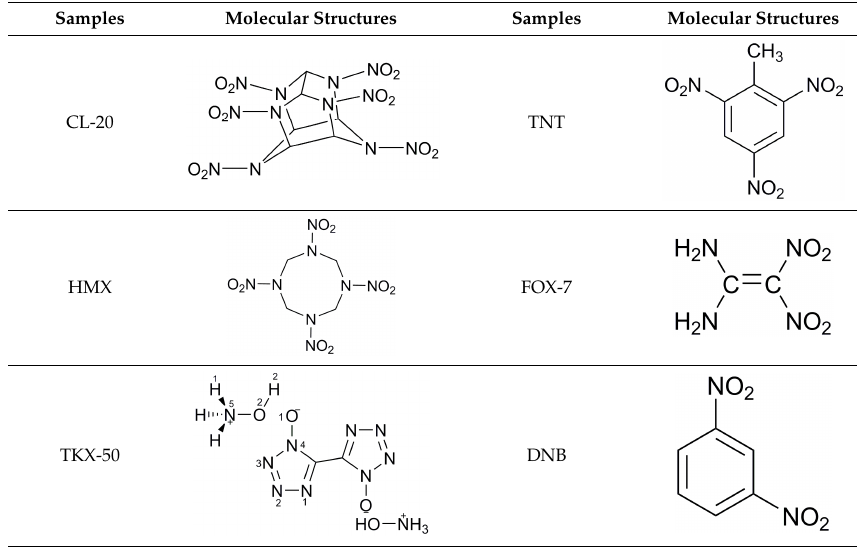
Table 1. Molecular structures of di ff erent energetic materials formed